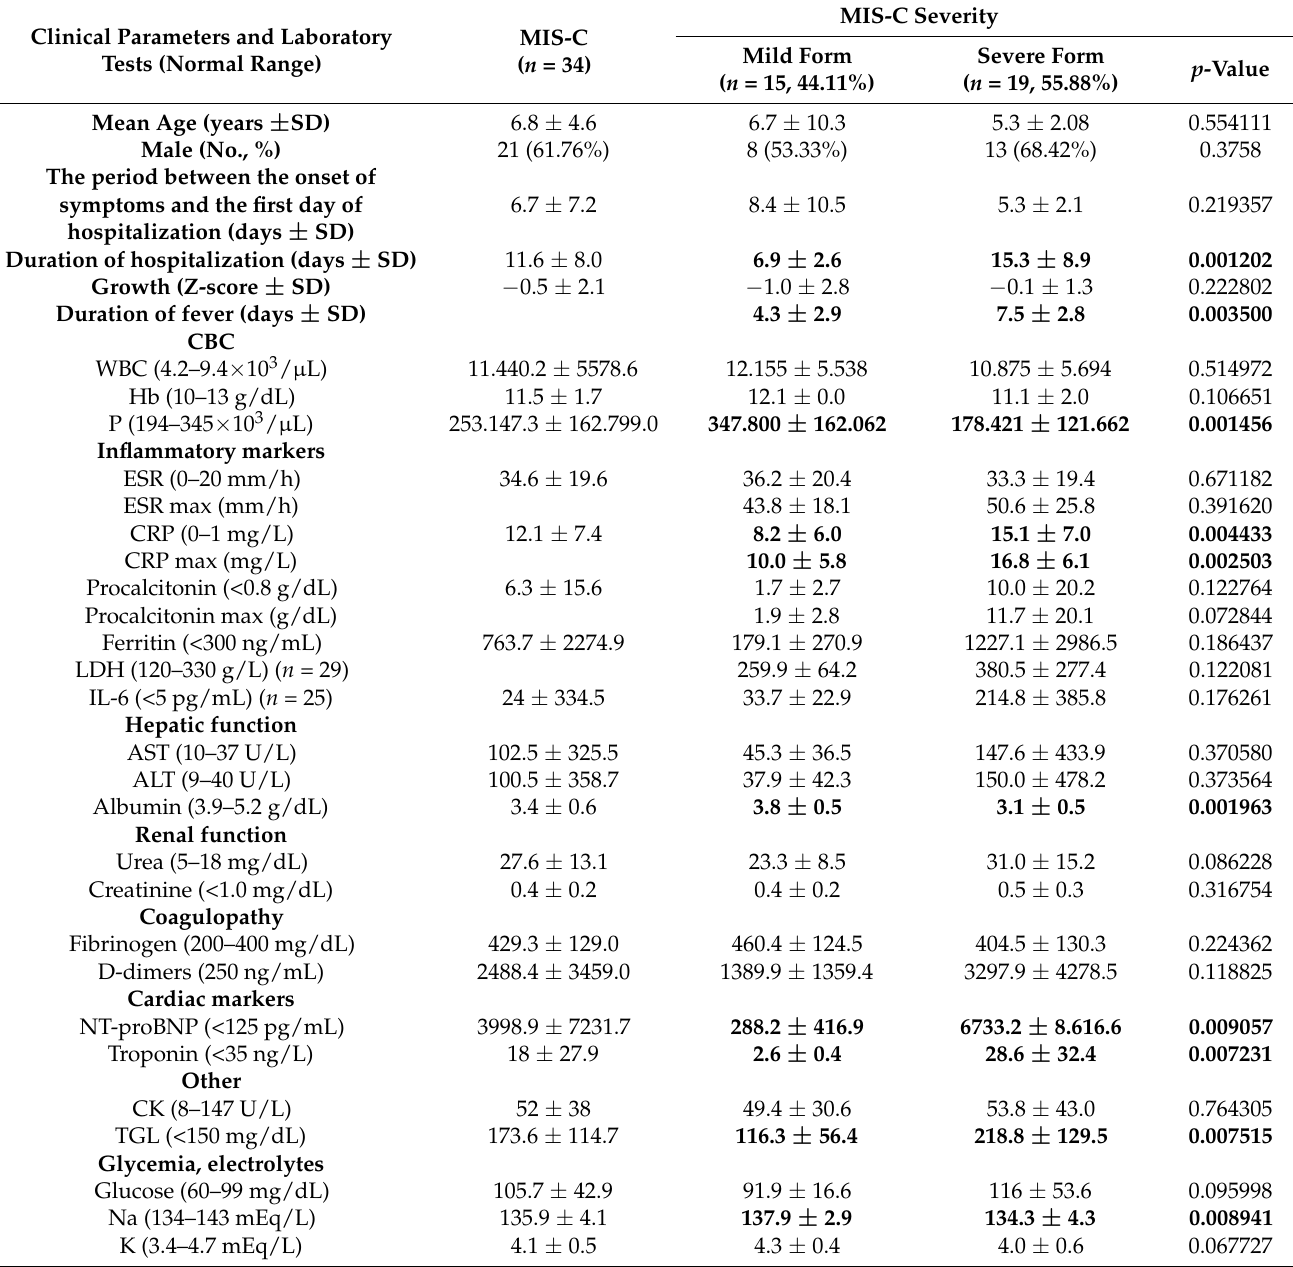
Table 2. Comparison between children with mild and severe